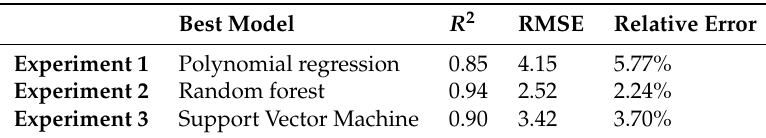
Table 8. Best model for each